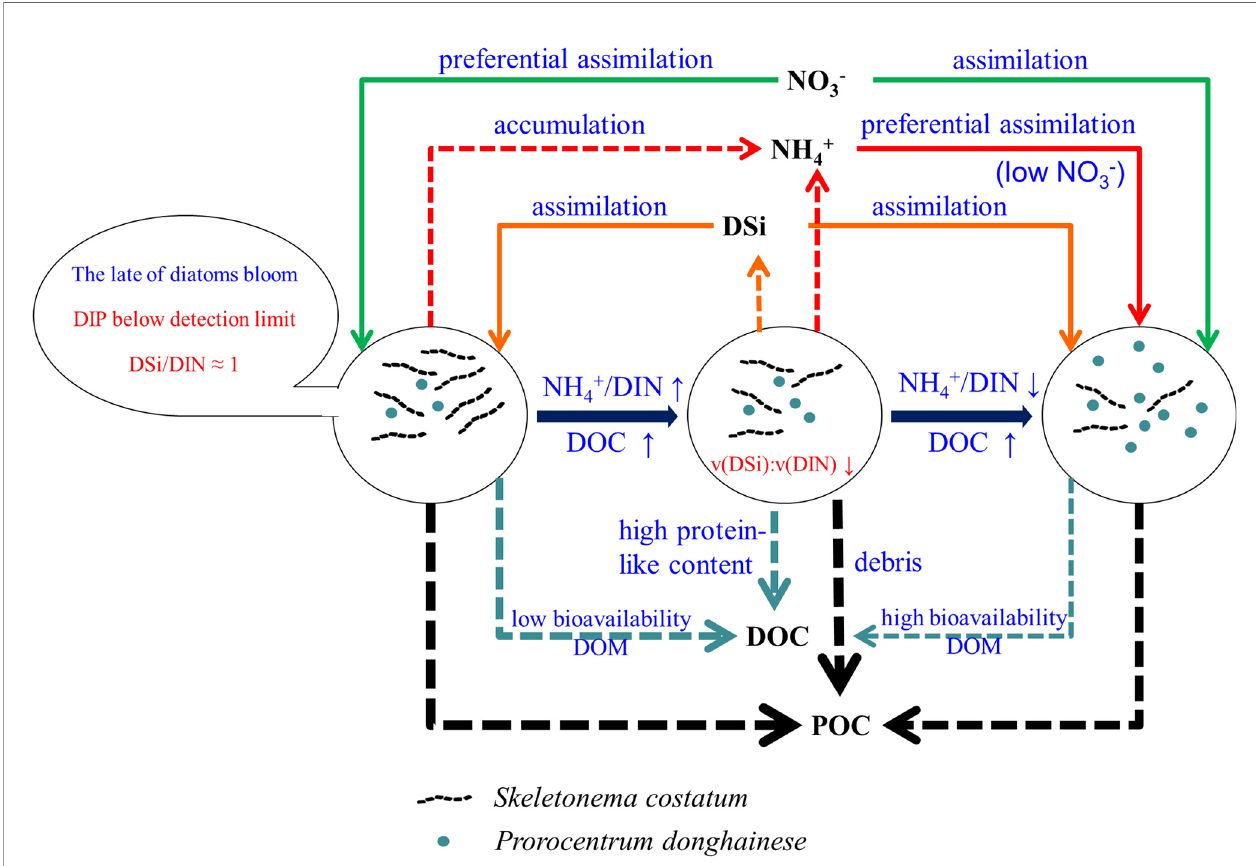
FIGURE 7 | A conceptual model of phytoplankton community succession process in natural Changjiang estuary. The dotted line means an increase of matter and the solid line means a decrease of matter in the incubation system. Line thickness of arrows indicate relative amount of